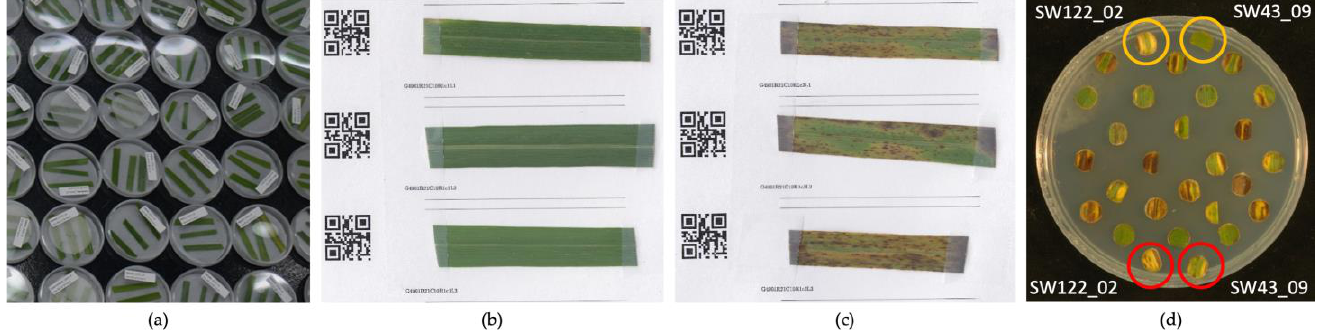
Figure 6. Detached leaf assay and leaf disk assay; ( a ) sealed plates of detached leaves under 12-h light 25 °C; ( b ) control inoculated and ( c ) inoculated leaves at seven dpi were taped on white paper with QR code label for scanning for image analysis. ( d ) A plate example of leaf disk assay at seven dpi. Each plate consisted of 28 leaf disks. SW43_09 was used as a resistant check and SW122_02 as a susceptible check. Two control leaf disks (yellow circles) and two inoculated leaf disks (red circles) were included in all plates. The rest of the leaf disks (24) consisted of eight genotypes with three replicates placed in a consecutive row from left to right.